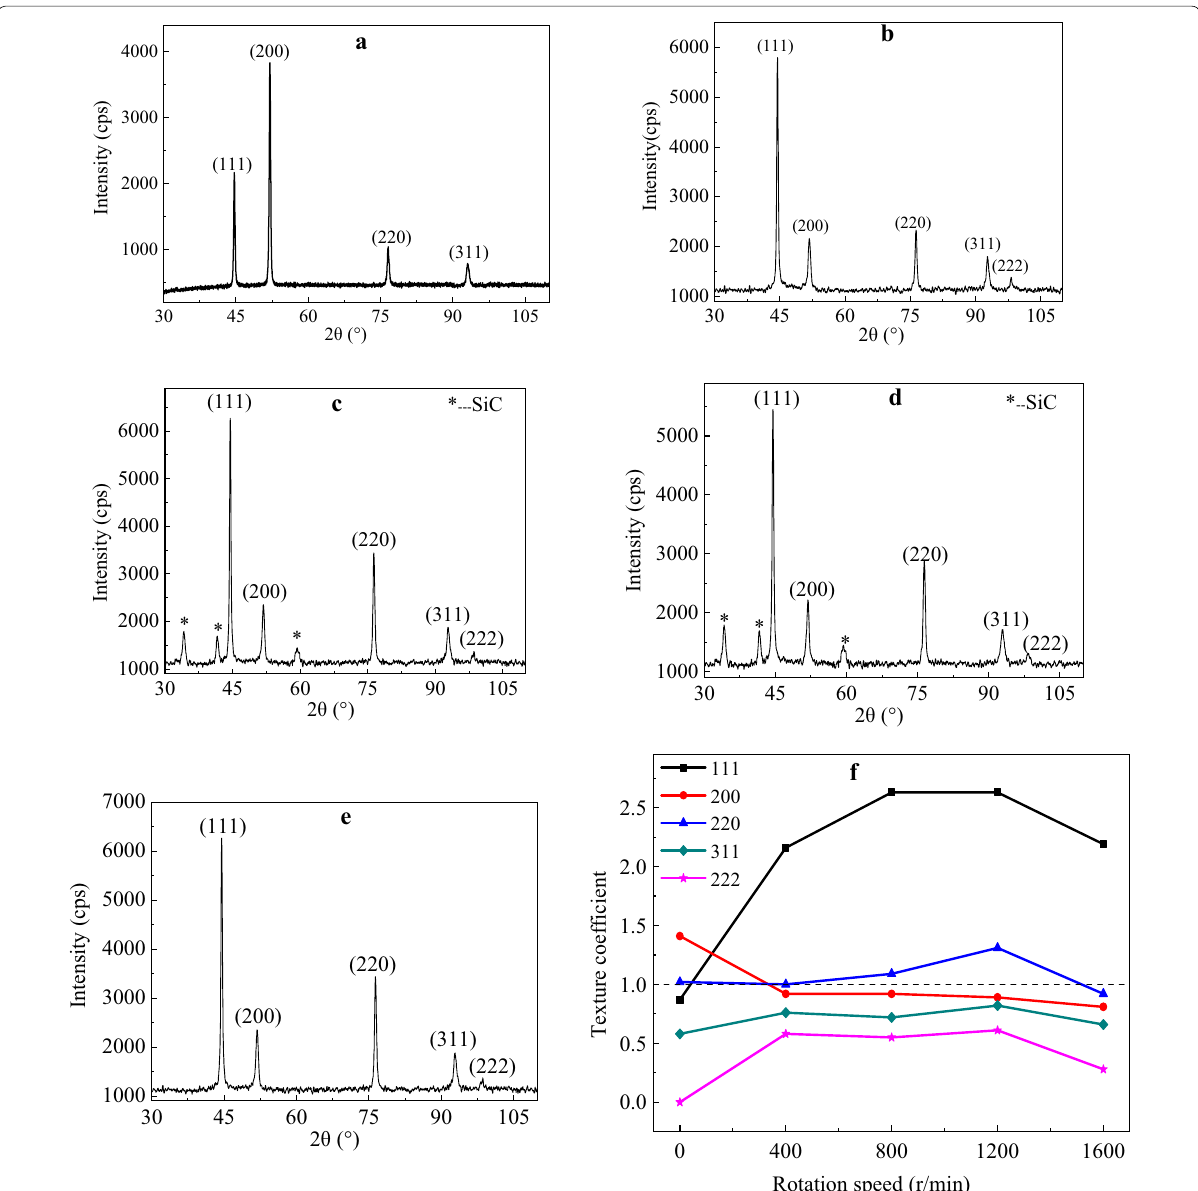
Figure 4 XRD patterns of deposited Ni–Co/SiC coatings under rotation speeds of: a 0, b 400 r/min, c 800 r/min, d 1200 r/min and e 1600 r/min. f Texture coefficient versus rotation